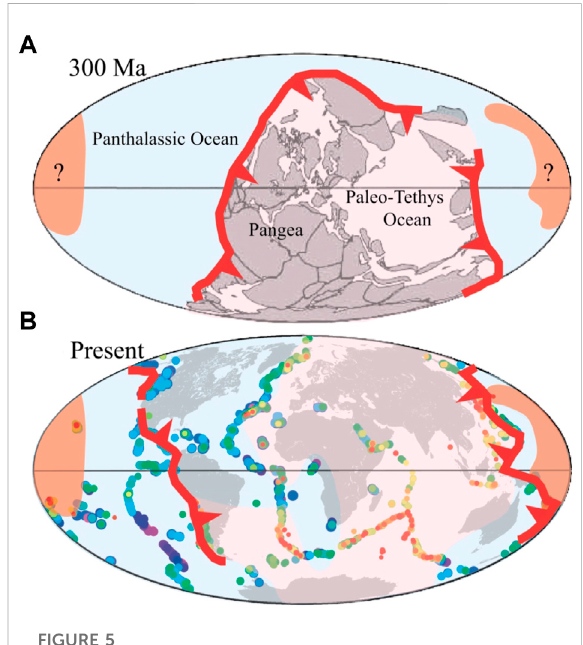
FIGURE 5 Evolution of the supercontinent Pangea and the underlying geochemical hemispheres (Iwamori and Nakamura, 2012). (A) The possible con fi guration at 300 Ma, where the pinkish area represents the hydrophile component-rich mantle developed beneath Pangea, whereas the reddish area represents hypothetical “ older domain ” developed beneath Rodinia. The bluish area represents the hydrophile component-poor domain developed beneath the Panthalassic Ocean. (B) The present-day con fi gurationwiththeobserveddistributionofIC2value,basedon which the high-IC2 domain (pinkish area with dominantly IC2 > 0) and low-IC2 domain (bluish area with dominantly IC2 < 0) are